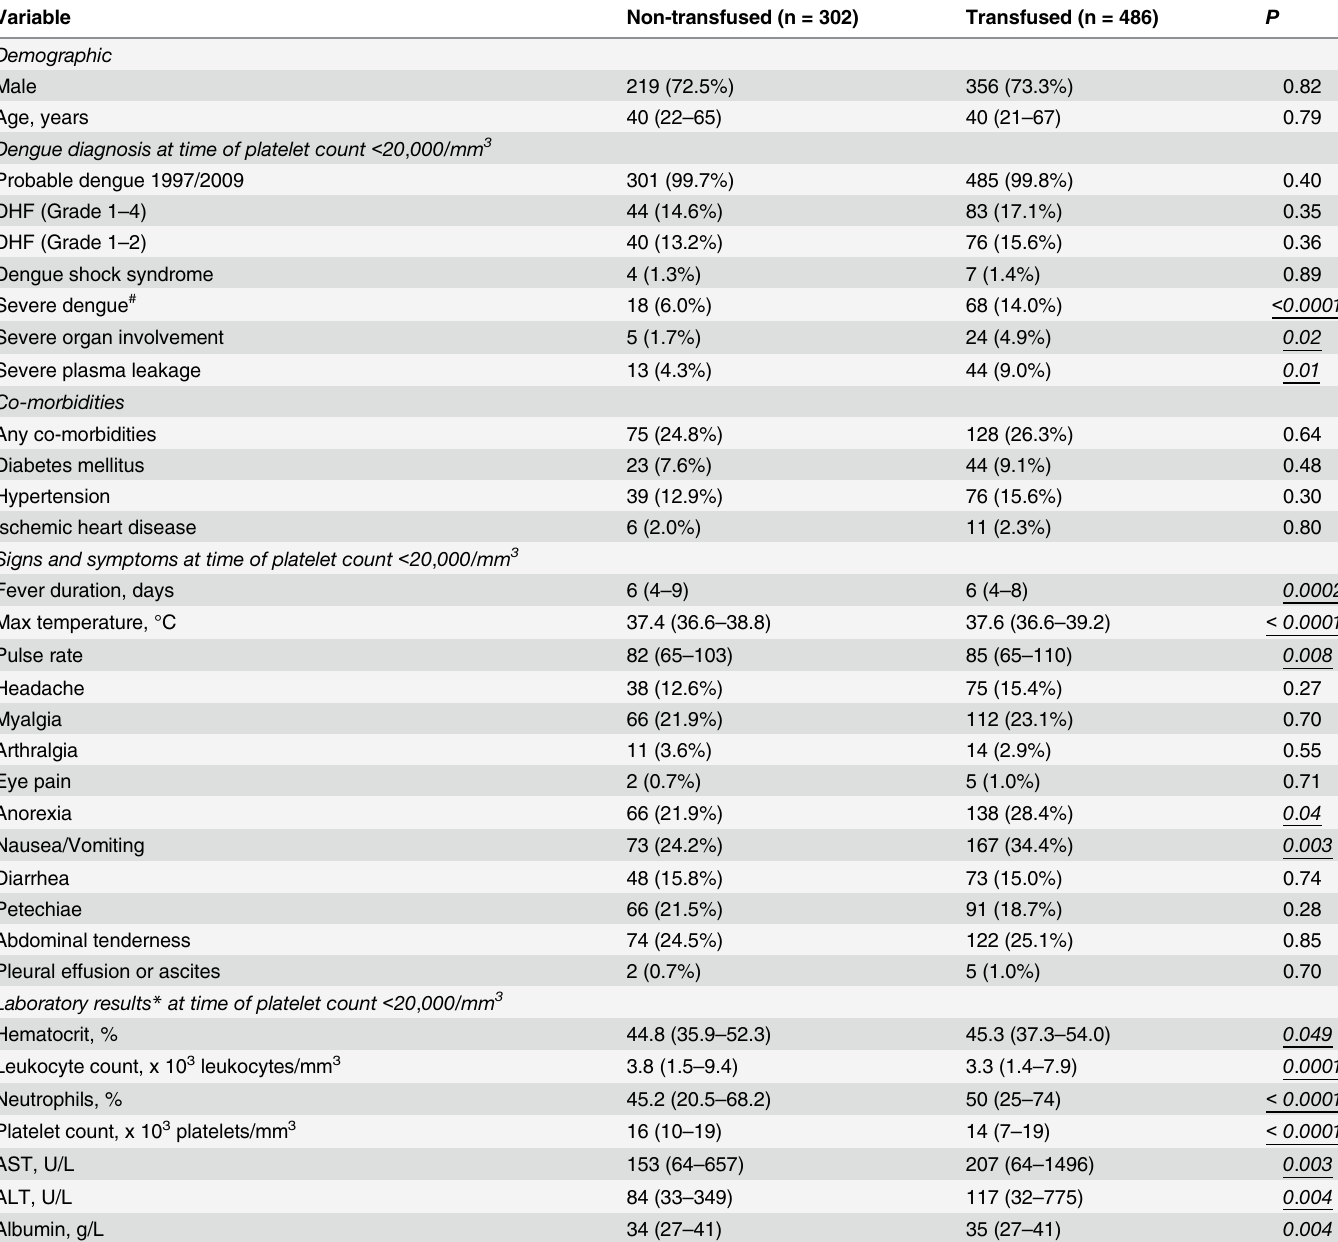
Table 1. Demographic data, dengue severity, co-morbidities, signs and symptoms and laboratory results of patients with and without prophylactic platelet transfusion.